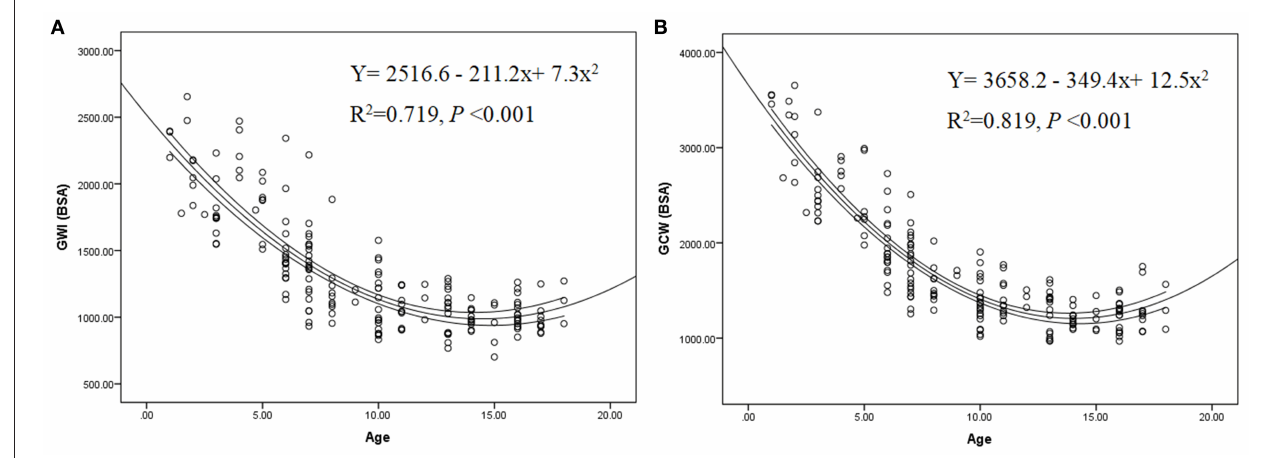
FIGURE 4 | The Bland–Altman analysis for assessing intra-observer variability of global work index, global constructive work, global wasted work, and global work efficiency. Lines represent bias and 95% limits of agreement for measurements performed in 20 subjects.